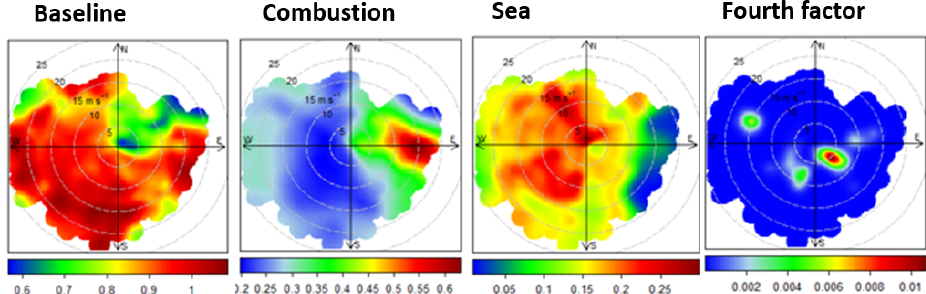
Figure 6. Polar plots for the factors obtained in the PMF solution. The plots show variations of mercury (ngm − 3 ) loaded in each factor as a function of wind direction ( ◦ ) and speed (ms − 1 ).